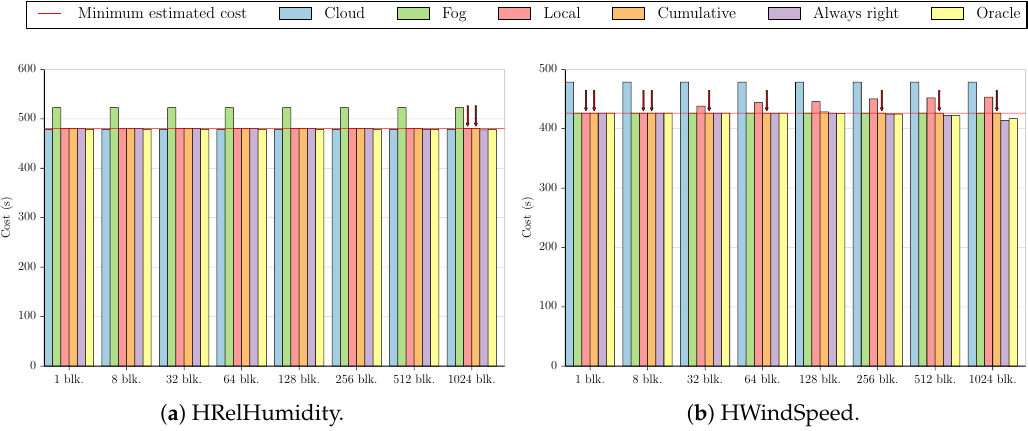
Figure 3. Summary of the results for MinMax [ − 5,5 ] fog-prone test cases.